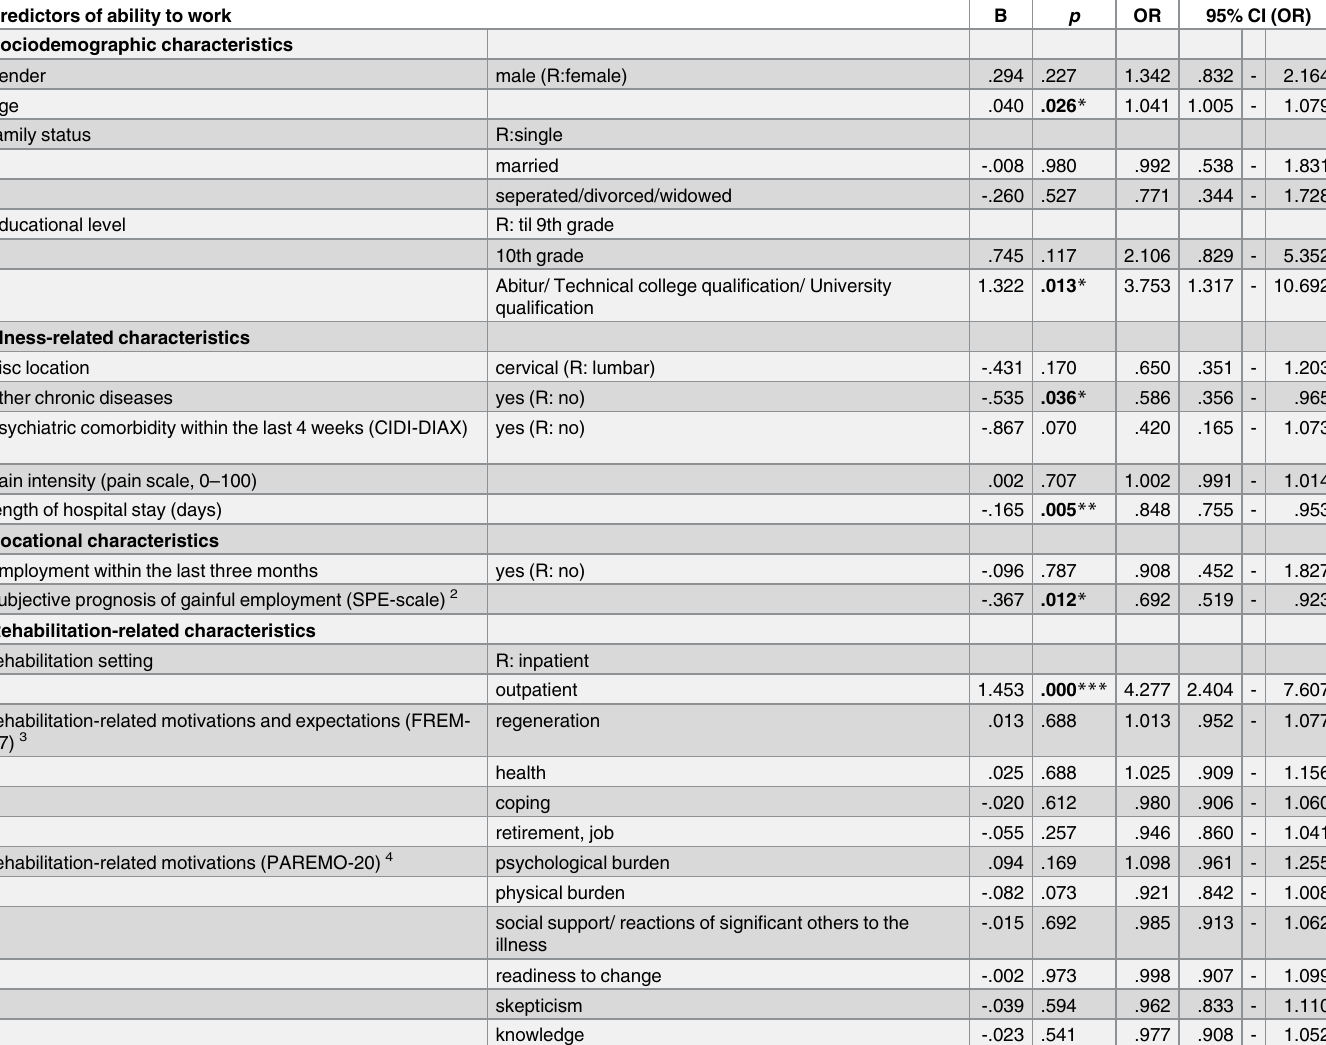
Table 2. Binary logistic regression model of factors associated with ability to work a three months after disc surgery (N = 428 b ). Predictors of ability to